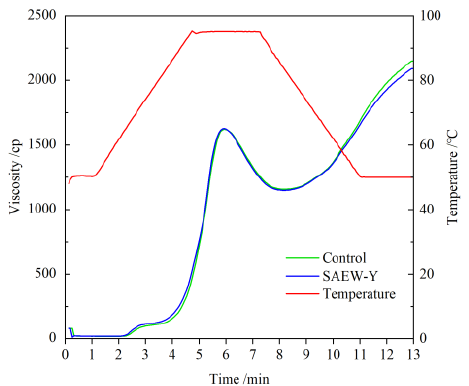
Figure 5. Pasting properties of control and SAEW tempering flour samples analysed using a Rapid Visco-Analyzer (RVA).